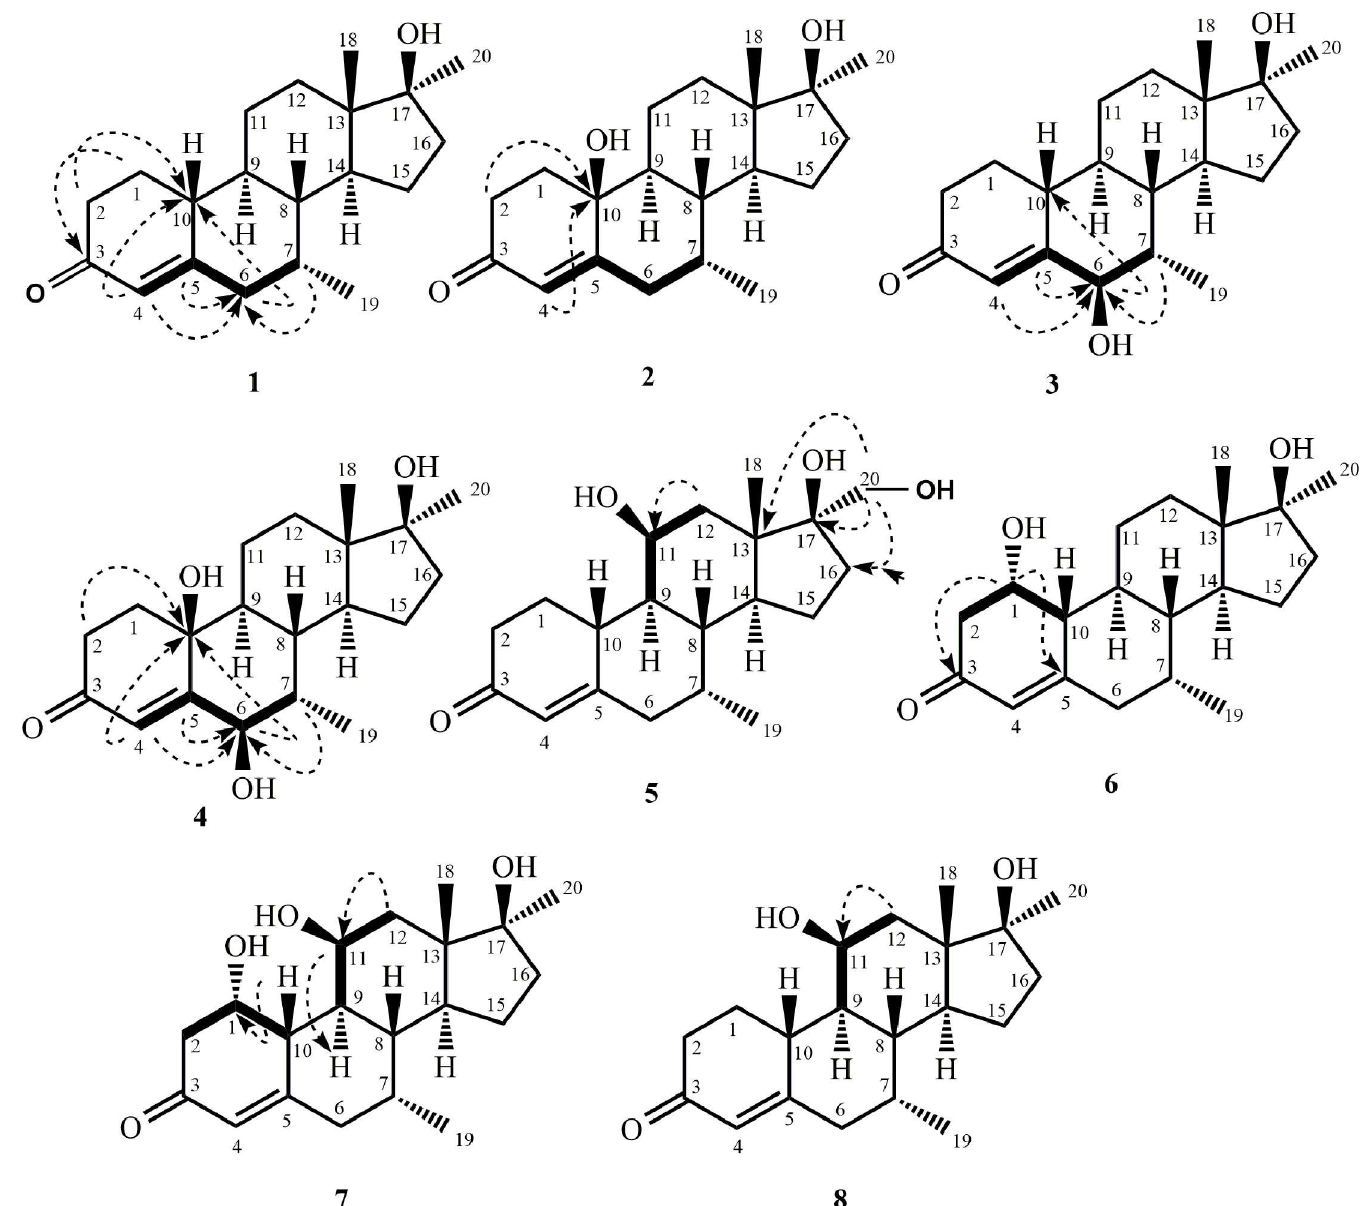
Fig 4. Key HMBC and COSY correlations of compounds